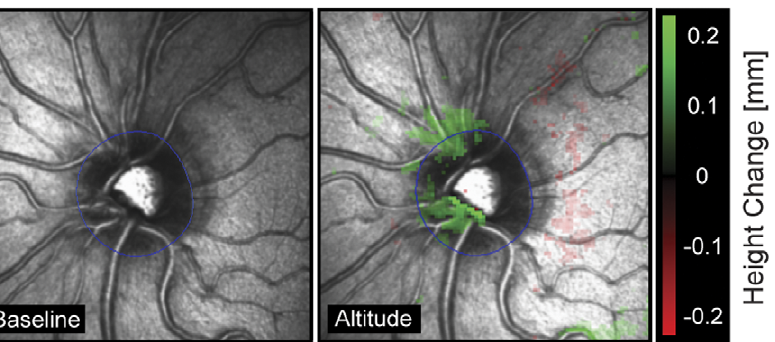
Figure 2. Automated Track Change Analysis (TCA) of the optic nerve head. Automated Track Change Analysis (TCA) of the optic nerve head shows increase in neuroretinal rim height in a representative participant between baseline recording (BL1, left) and recording at high altitude (day2, right). The change is color coded with green indicating an increase of tissue (see scale on the right).